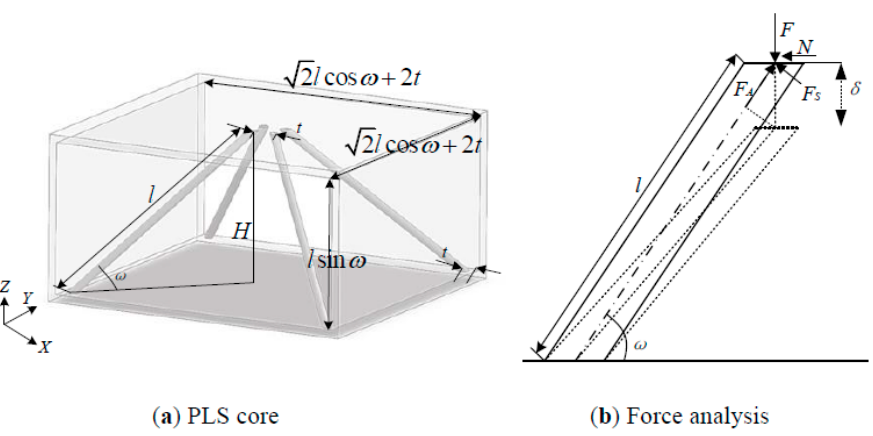
Figure 5. Force analysis of the single member of the PLS core: ( a ) PLS core; and ( b ) force analysis.